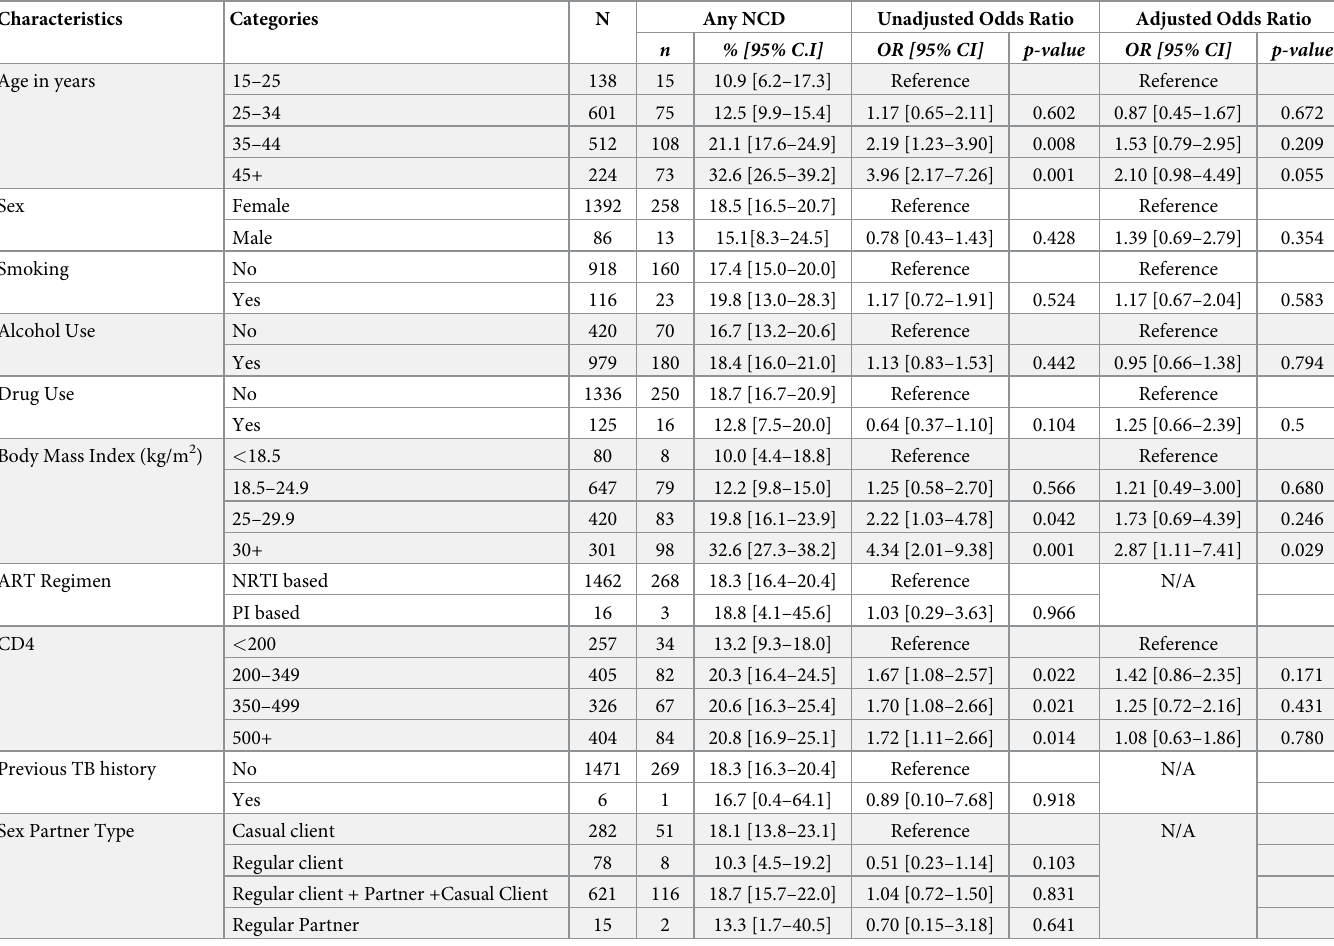
Table 4. Risk factors for NCDs among key populations living with HIV at SWOP Clinics in Nairobi, Kenya, 2012–15.